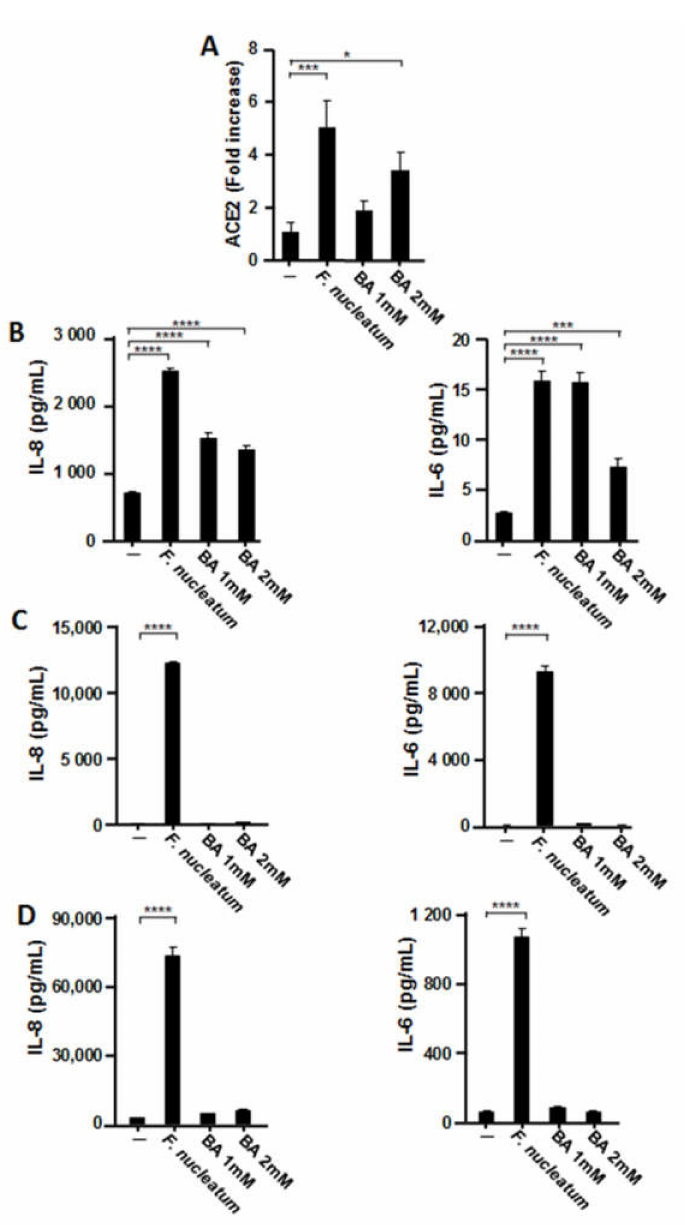
Figure 5. Effects of butyric acid (BA) on ACE2 and proinflammatory cytokine expression in respira- tory epithelial cells. A549 cells were incubated with CSF (100 µ L/mL) or BA (1 or 2 mM) for 48 h ( A ). The mRNA levels were normalized to those of glyceraldehyde-3-phosphate dehydrogenase and expressed as fold increases. A549 ( B ), BEAS-2B ( C ), and Detroit 562 ( D ) epithelial cells were incubated with CSF (100 µ L/mL) or BA (1 or 2 mM) for 48 h. IL-8 and IL-6 protein levels in the cell culture supernatants were determined via enzyme-linked immunosorbent assay. These experiments were conducted in triplicate, and data are presented as the mean ± SD; n = 3 (*, p < 0.05; ***, p < 0.005; ****, p <